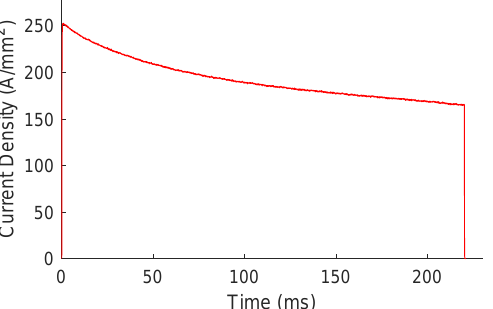
Figure 22. DC pulse of approximately 200 A/mm 2 using the battery bank power supply.